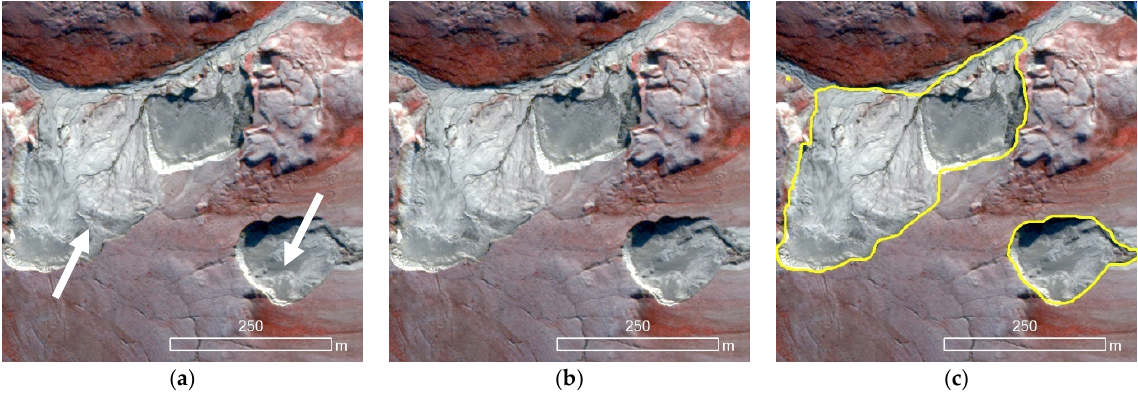
Figure 23. Example zoomed-in views capturing model transferability across study sites. ( a ) Original image from Banks Island. ( b ) The DLCNN model trained on Eureka Sound Lowlands’ RTS samples and applied to Banks Island. ( c ) The DLCNN model trained on combined RTS samples and applied to Banks Island. White arrows indicate the location of RTS. Underlying imagery is at 0.5 m resolution with false color composite.